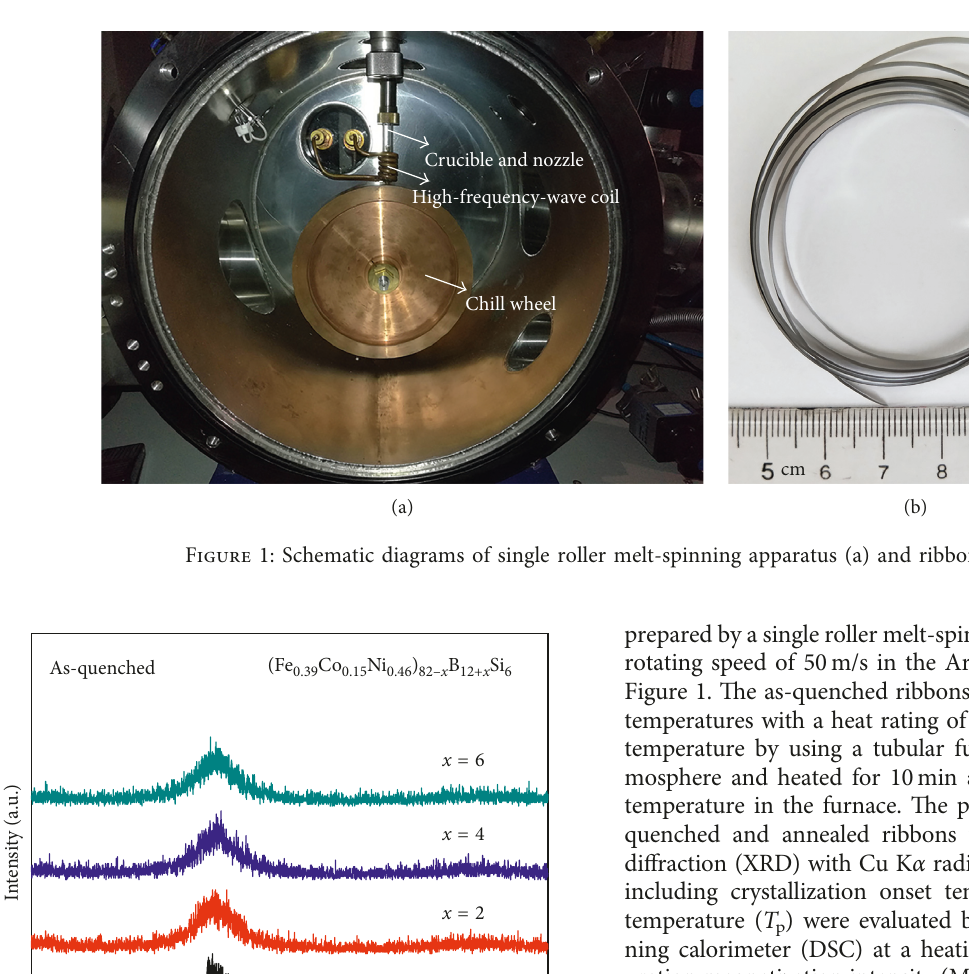
x B 12+ x Si 6 as- −